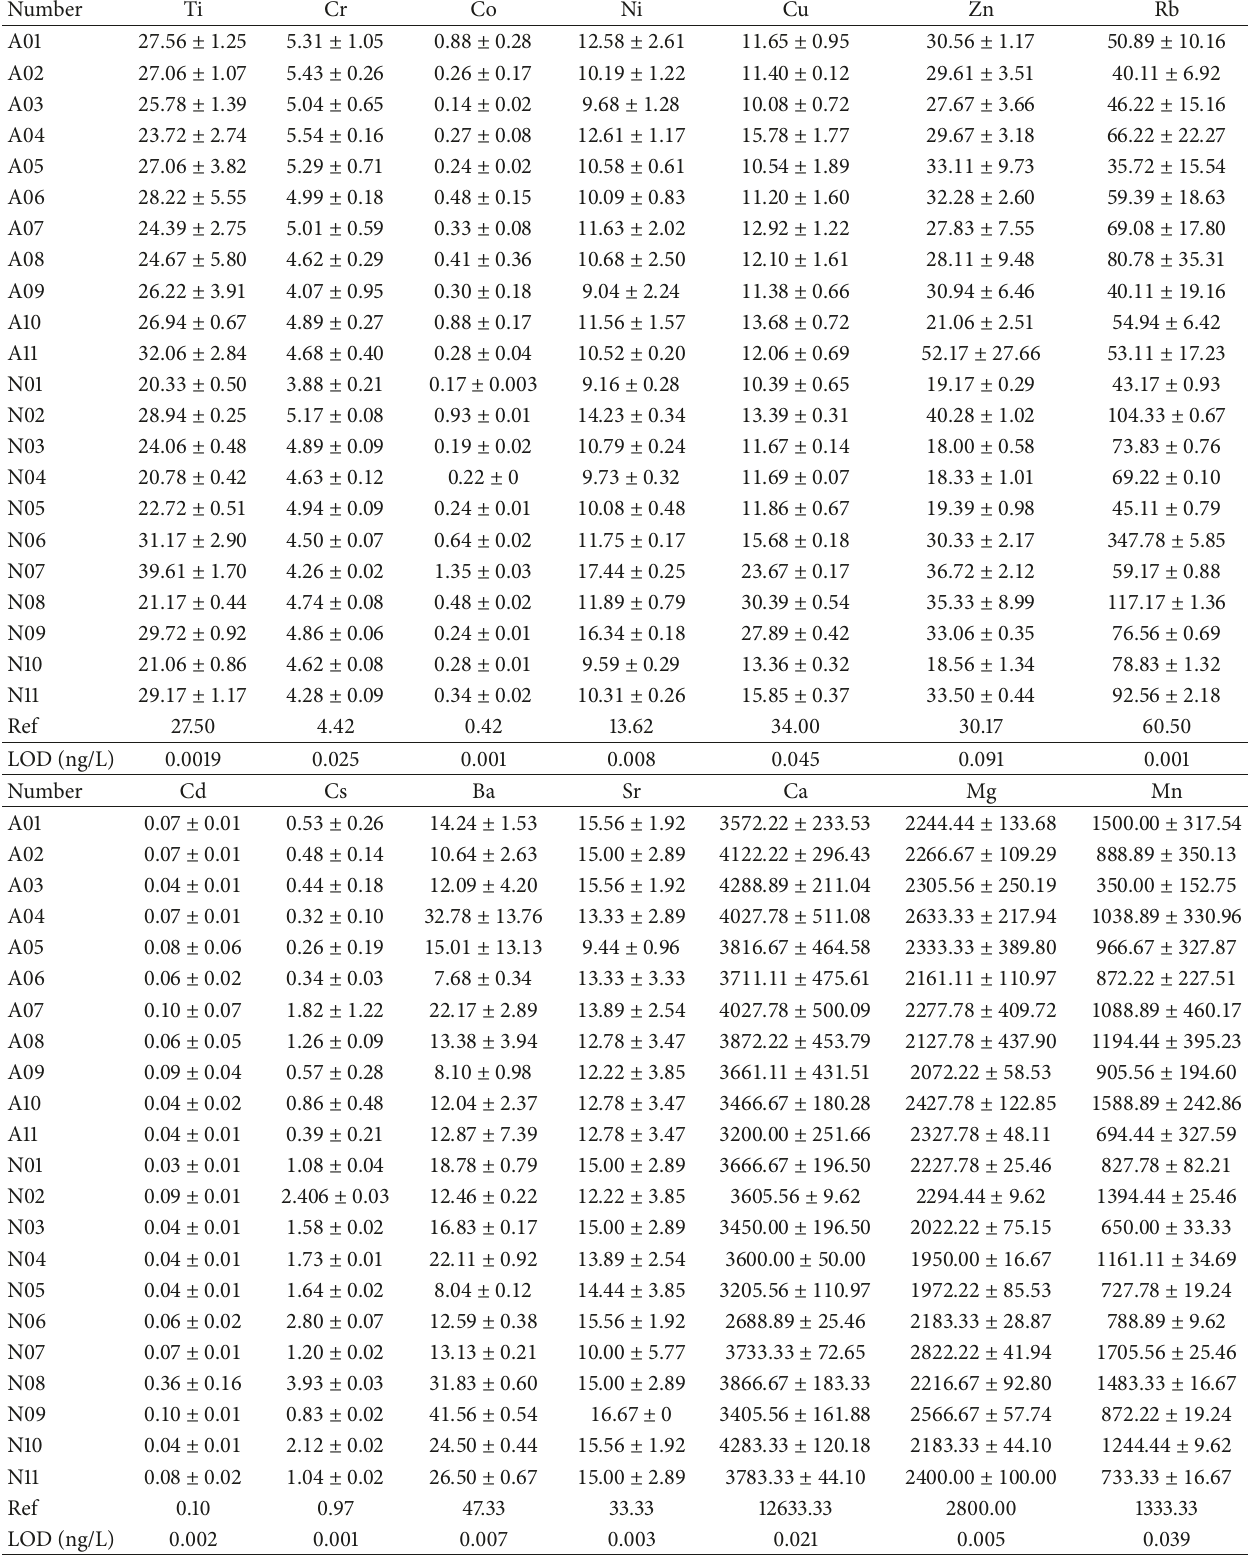
Table 5: Results of provenance experiment: averages values of 14 element concentrations ( 𝜇 g/g) in WRT and NWRT